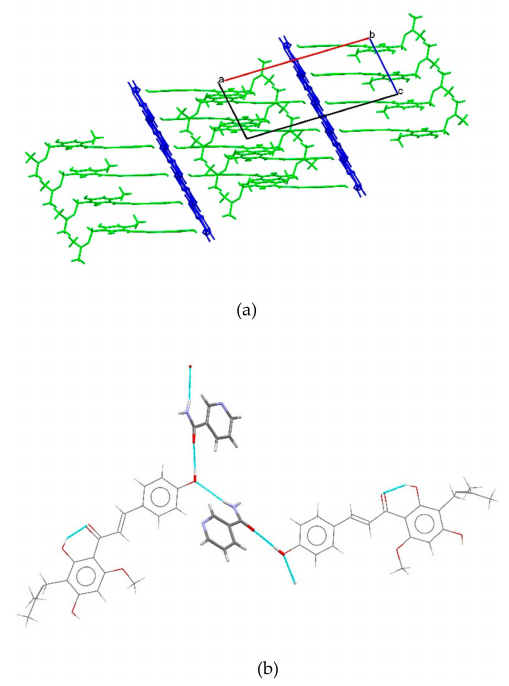
Figure 6. Crystal packing and interactions in the XN − NIC cocrystal showing ( a ) a layered section of XN structure and nicotinamide columns crossing them and ( b ) an infinite hydrogen bond chain C(6) in the XN − NIC cocrystal.